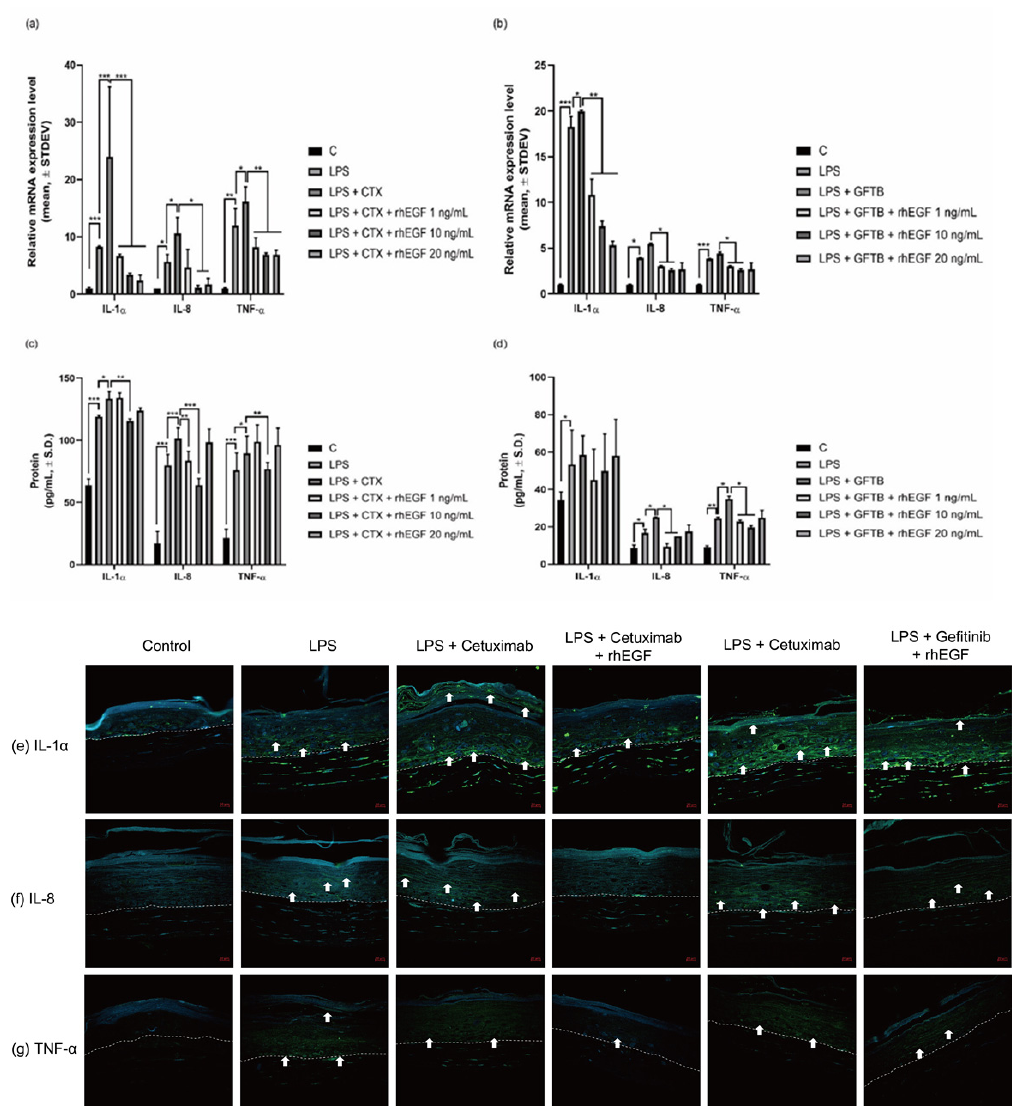
Figure 4. EGFRI-induced inflammatory cytokine expression was inhibited by rhEGF treatment. IL-1 α , IL-8, and TNF- α mRNA expression was increased in keratinocytes treated with cetuximab or gefitinib ( a , b ). However, that increment was decreased by rhEGF and cetuximab ( a ) or gefitinib ( b ) co-treatment. The protein expression of IL-1 α , IL-8, and TNF- α also induced cetuximab ( c ) or gefitinib ( d ) treated keratinocytes ( c , d ), and that was inhibited by rhEGF and EGFRI co-treatment ( c,d ). IL-1 α expression was observed in the epidermal layer (white arrow) ( e ). The expression of IL-8 was slightly observed in the epidermis (white arrow) ( f ). TNF- α expression was seen in the epidermal layer (white arrow) ( g ). Results are presented as mean ± standard deviation (S.D.), representative of three separated experiments. Asterisks indicate statistically significant differences (* p < 0.05, ** p < 0.01, *** p < 0.001). (Magification, ×20, Scale bar: 20 μ M)